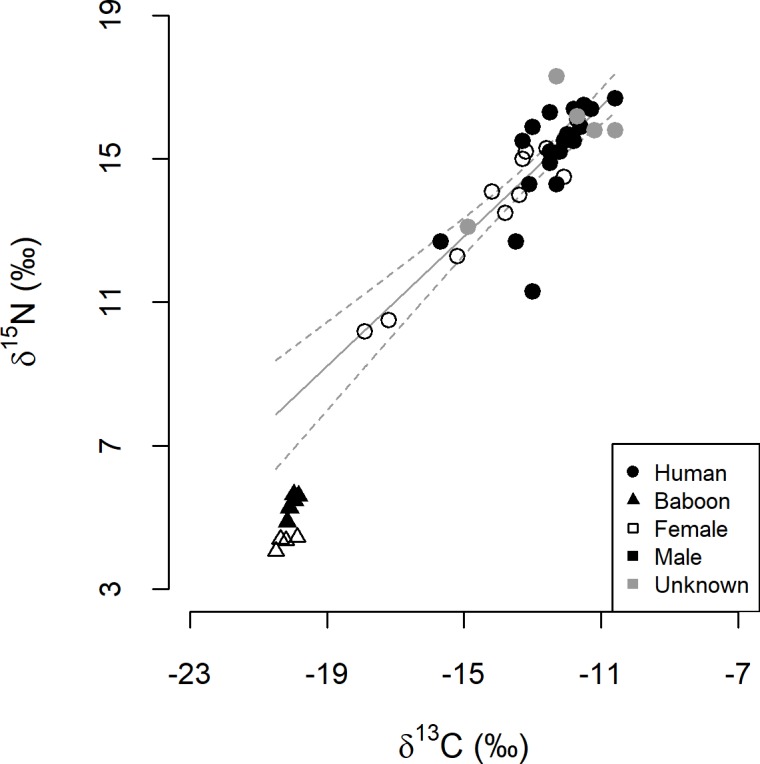
Isotope ratios of Later Stone Age human bone samples and modern baboon hair samples.Symbols denote species and sex as stated in the legend. The solid line depicts the relationship between human δ13C and δ15N values, described by δ15N = 0.9 × δ13C + 26.4 (dashed lines indicate 95% confidence intervals). The lines are extended beyond the range of human values to show how baboon values relate to the output from the regression analysis.